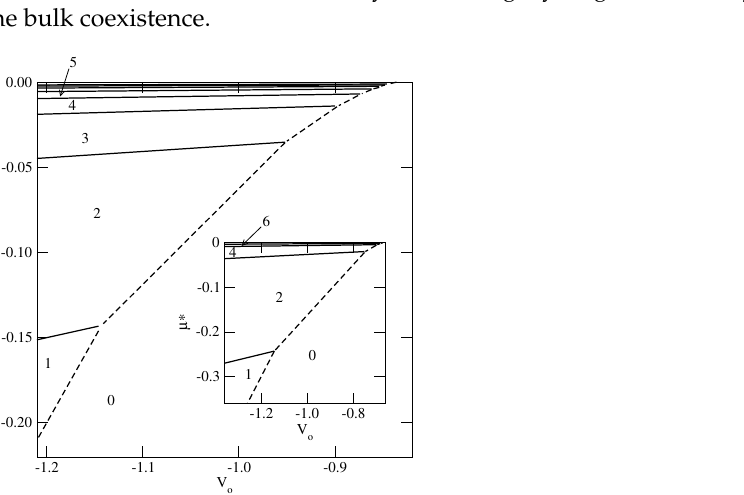
Figure 6. The ground state phase diagrams for u AB = 0 and u BB = − 1.0 (the main figure) and for u BB = − 0.8 (the inset). The regions with different numbers of occupied layers are marked in the